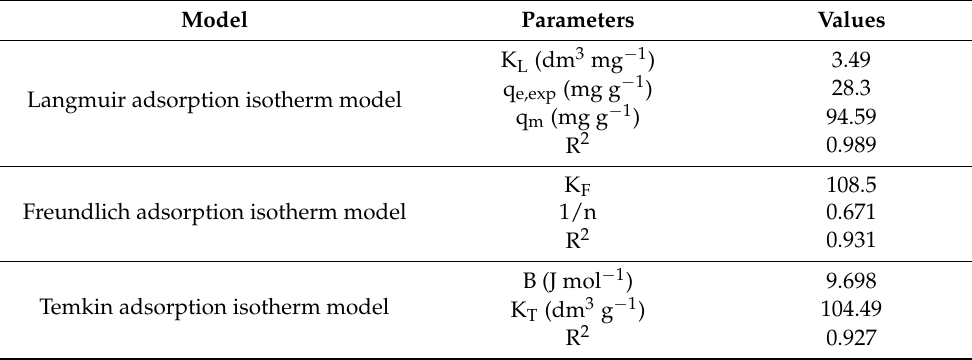
Figure 6. Biosorption isotherm data fitted using non–linear Langmuir, Freundlich and Temkin models. Table 2. Adsorption isotherm model parameters for copper ions biosorption onto eggshells.